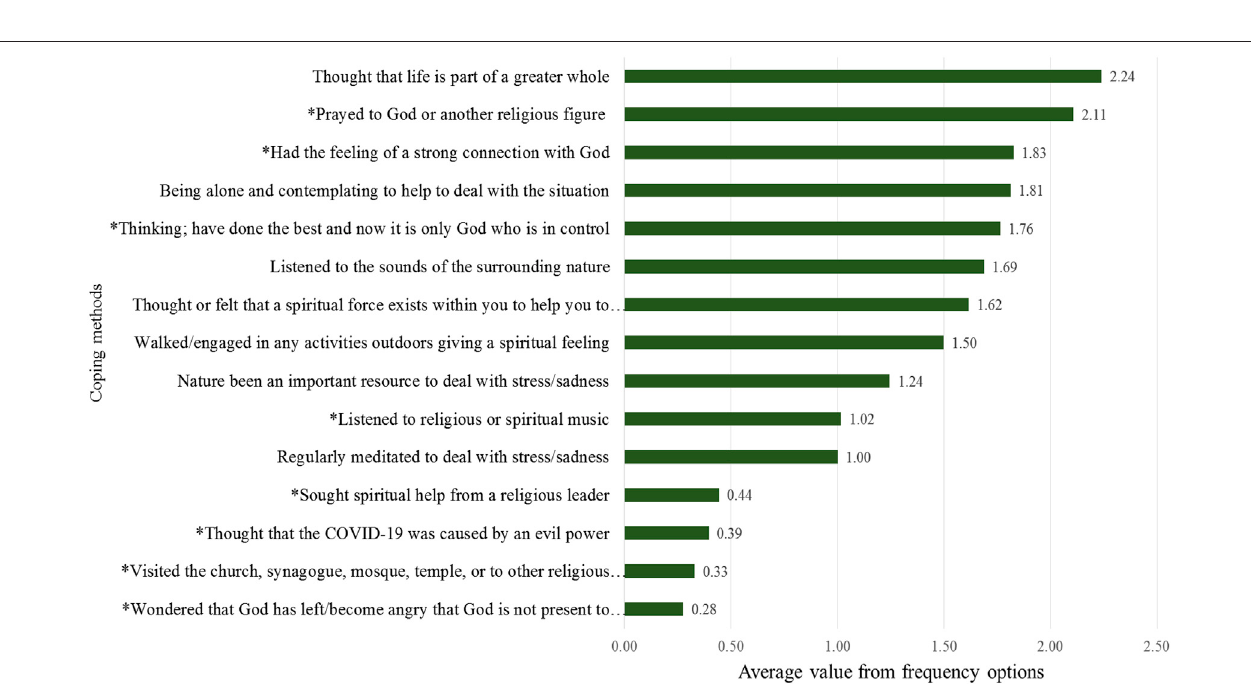
FIGURE 4 | Ranking list based on frequency of meaning-making coping methods